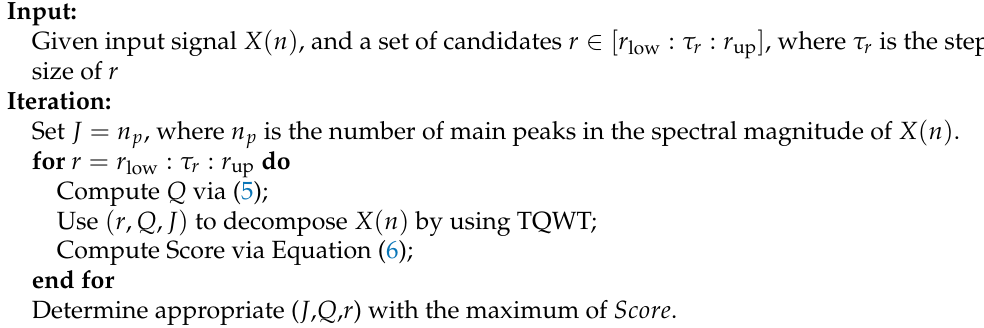
Algorithm 1 Algorithm for ( J , Q , r ) selection in